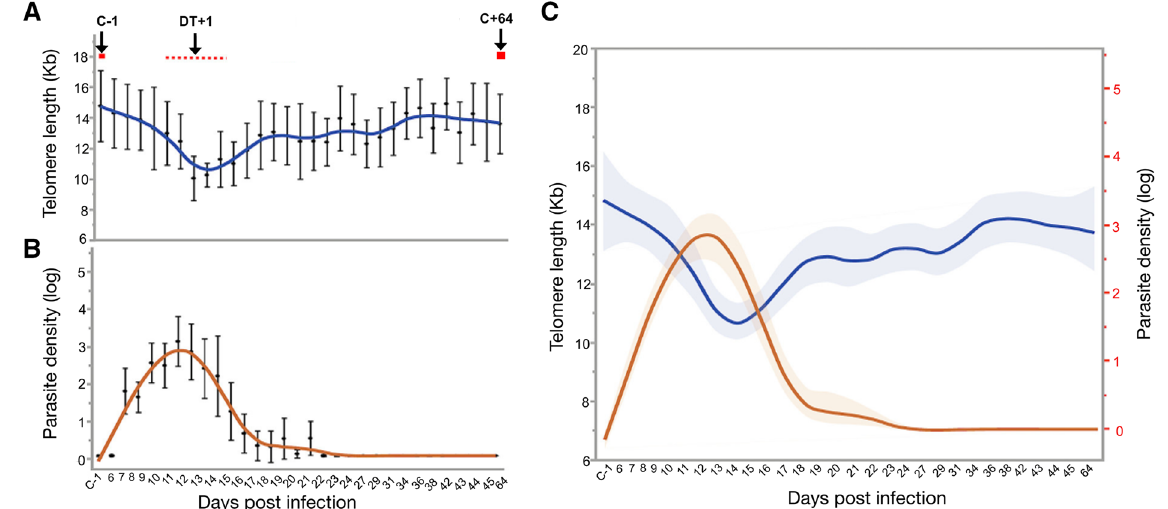
Figure 1. Telomere length and P. falciparum parasite densities before, during and after a controlled human malaria infection (CHMI). ( A ) Telomere length dynamics in kilobase pairs (kb) on respective study days of malaria infection. Arrows indicate the study time point prior infection (C-1, base line sample), day post treatment (DT+1), and time of end treatment/end of study (C+64). ( B ) Log values of P. falciparum parasite density ( Pf /mL blood) during malaria infection. Peak parasite density was observed during day 11–12, and ranged from 2435 to 197,500 Pf /mL (median 22,092 Pf /mL), corresponding to 0.000062–0.0049% infected red blood cells (iRBC; median 0.00055%). Solid blue and orange lines represent predicted means, with black dots representing the detected mean value at each time point. Error bars denote the 95% CI of the mean. ( C ) Relationship between telomere length (kb) and parasite density (log values) during malaria infection. Solid blue line represents predicted mean of telomere length, solid orange line represents predicted mean of parasite, with shaded areas denoting the confidence of the mean, (N = 16, observations TL = 481, observations parsitaemia =